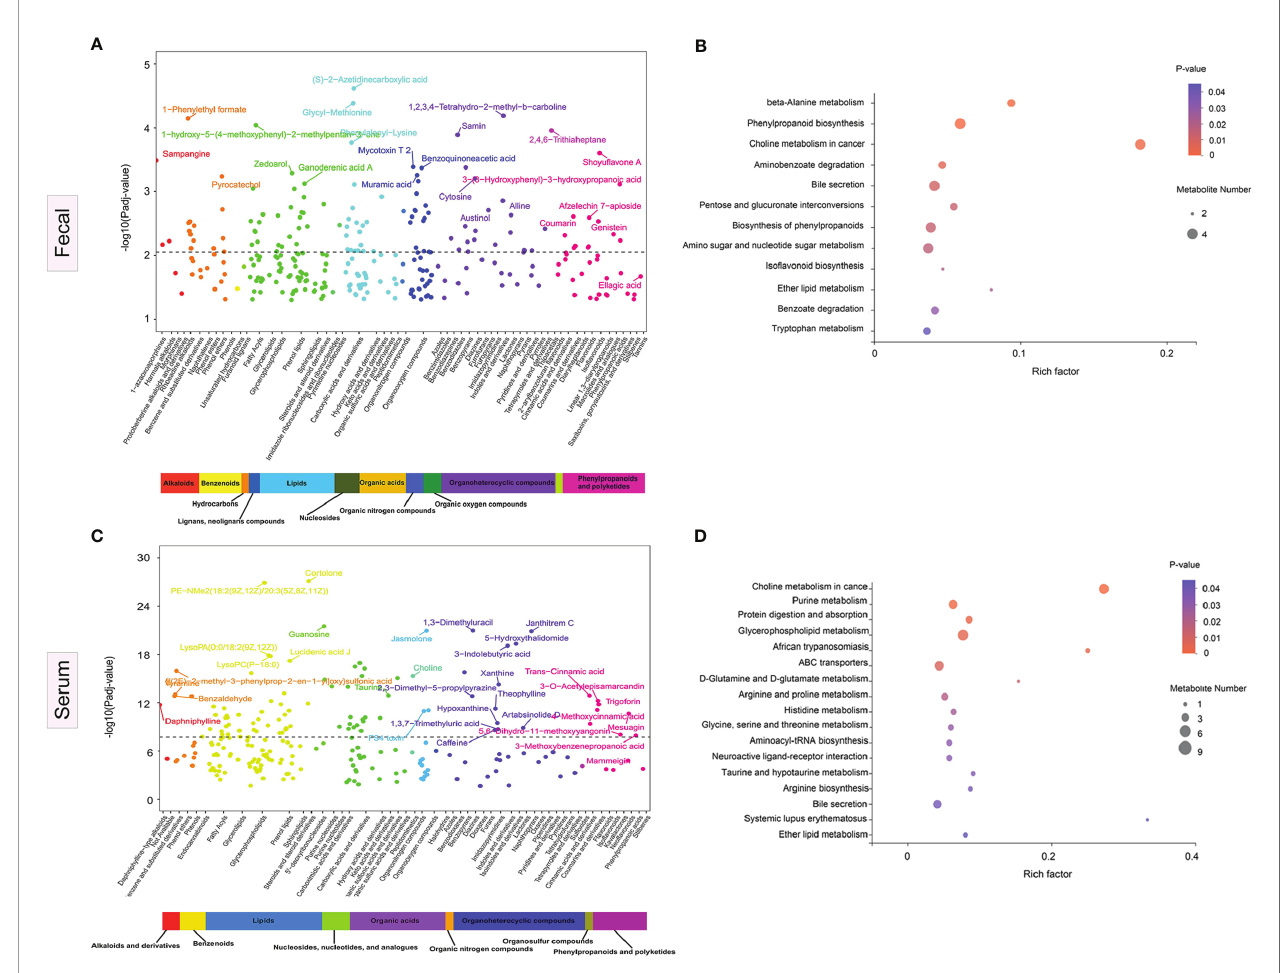
FIGURE 5 | Signi fi cance plot for the adjusted selected differential metabolites in anti- N -methyl- D -aspartate receptor (NMDAR) encephalitis cases vs. healthy controls by sub- and super-pathway level. (A, C) Each signi fi cantly selected fecal (A) and serum (C) metabolites sub-pathway is represented. The − log10( P adj ) for each metabolite is displayed by respective sub- and super-pathway ( P adj , adjusted p -value). Unadjusted Wilcoxon rank-sum test p -values were adjusted for multiple comparisons using Benjamini – Hochberg (BH) correction to yield adjusted p -values. The dashed line represents the adjusted p -value. Asterisks represent compounds that were not veri fi ed against a standard, but whose identity the analytical platform was con fi dent in. (B, D) Signi fi cantly enriched sub-pathways from metabolites selected using partial least squares discriminant analysis (PLS-DA) models are illustrated in dot plots. Each signi fi cantly selected fecal (B) and serum (D) sub-pathway is denoted by a circle described by three parameters. Circle size shows how many of the metabolites were selected in the sub-pathway (see legend in gray to the right of the plot for relative sizes). Circle shades from light pink to red denote selected sub-pathway signi fi cance levels based on − log10( p -value) (see legend to the right of the plot for relative color gradient). Sub-pathways were markedly enriched if p < 0.05, which was comparable to − log10( p -value) > 1.3. Circle position along the rich factor axis shows the abundance of the selected metabolites from the sub-pathway against all sub-pathway